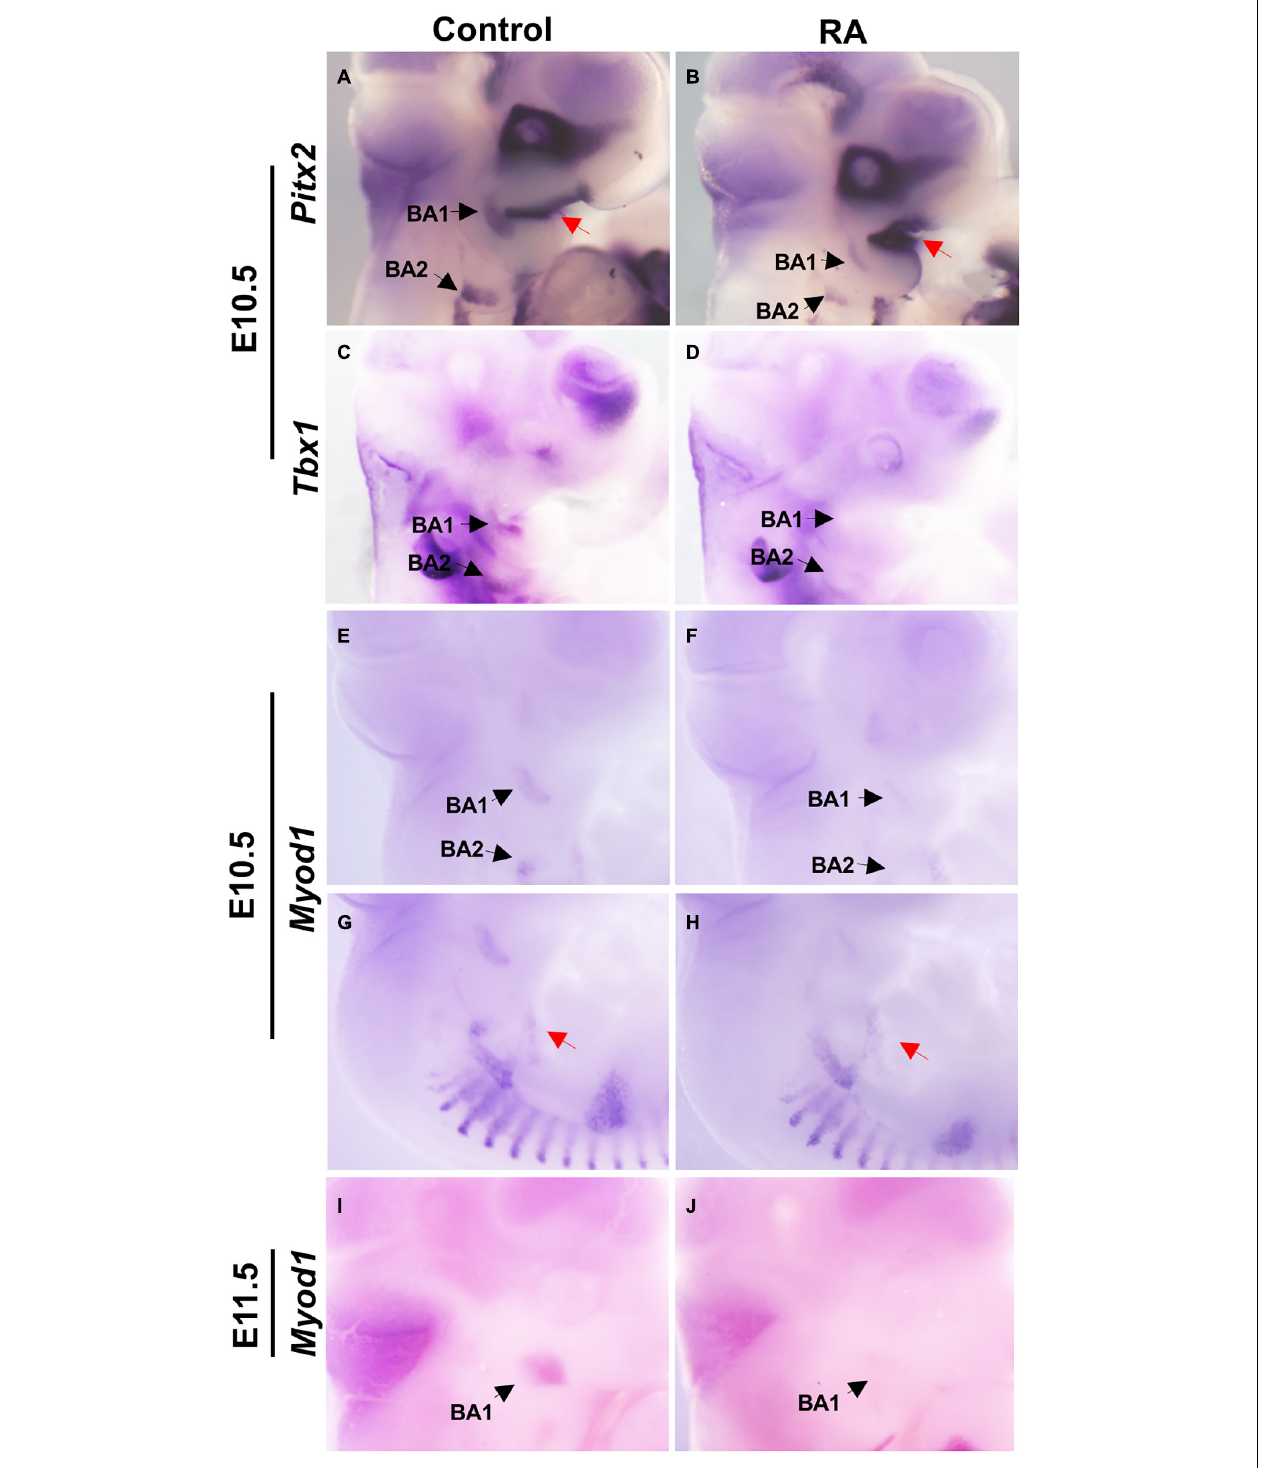
FIGURE 2 | Disruption of early myogenic markers in BA1 and BA2 of RA-treated embryos. Lateral views of whole-mount in situ hybridization for Pitx2 (A,B) , Tbx1 (C,D) , and MyoD1 (E–J) in E10.5-E11.5 BA1 and BA2 of control (A,C,E,G,I) and RA-treated (B,D,F,H,J) embryos. In BA1 and BA2 at E10.5, the expression of the early markers of myogenic specification, Pitx2 (A,B) and Tbx1 (C,D) , is severely affected by the RA treatment. However, the expression of Pitx2 is higher in the oral ectoderm in RA-treated embryos ( A,B , red arrows). (E–J) MyoD1 , a marker of myogenic determination, fails to be expressed in the BA1 and BA2 in embryos treated with RA at E10.5 and E11.5, but no significant change is observed in the hypoglossal cord ( E,F , red arrows). Black arrows denote BA1 and BA2 hybridization signal or absence of signal.